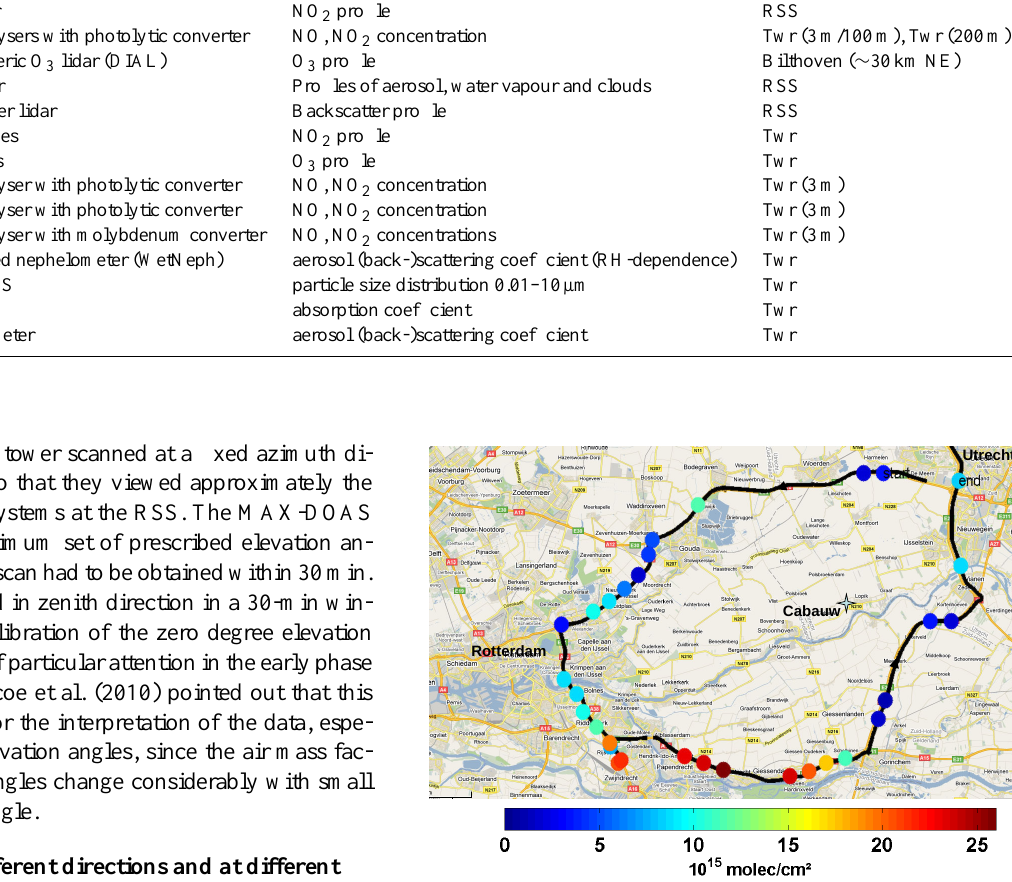
Fig. 5. Mobile measurements around Cabauw with the mini-MAX- DOAS instrument of MPIC Mainz in the morning of 12 June. The wind was coming from west to north-west, with a speed of 4.5ms − 1 . The track displayed runs (anticlockwise) over major highways. The colours indicate measured tropospheric vertical NO 2